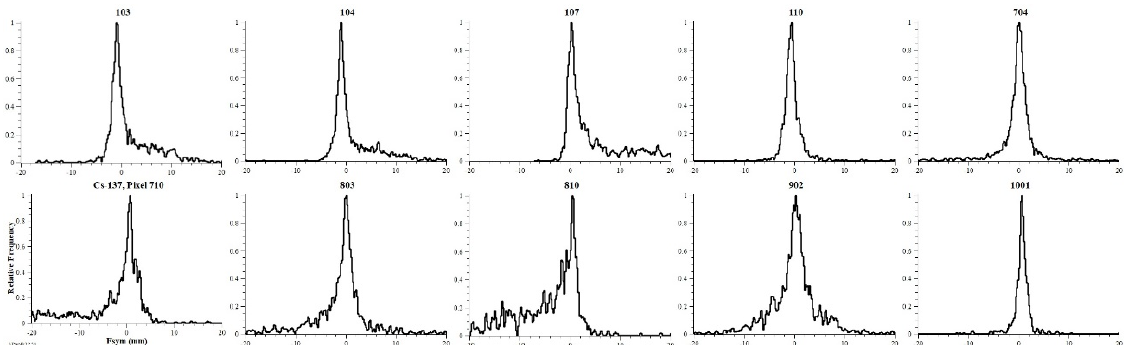
Figure 14. Fsym spectra from Cs-137 data regarding the selected decuple of pixels of the crystal-array with the best charge- symmetry response. Spectra are shown, from top-left to bottom-right, in ascending RRCC crystal-pixel order. Common axes titles and plot descriptions are reported only once in the bottom-left frame for better clarity. The selection criterion, based on Euclidian distances from origin in the plane (Average, Standard Deviation), founded the best decuple of zero-centered spectra made by pixels 103, 104, 107, 110, 704, 710, 803, 810, 902, and, 1001, whose distance values from origin ranged from 0.56 to 1.42 mm.